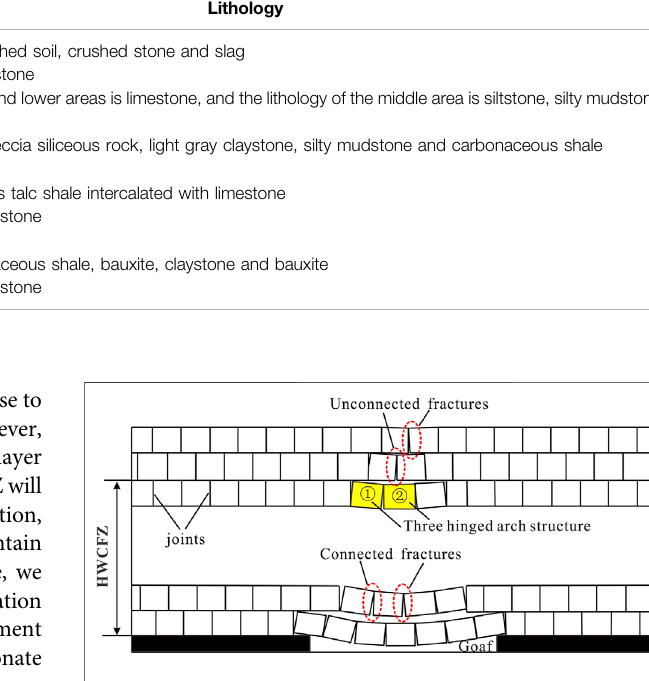
FIGURE 2 | Sketch map of rock layer ’ s three-hinge arch failure after